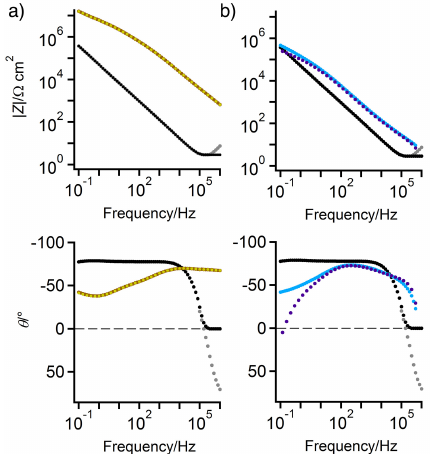
Figure 3. Impedance modulus and phase plots depicting the subtraction of the cell impedance from test panel spectra W (column a) and PA (column b). For all plots, both the cell impedance (gray) and the high frequency corrected cell impedance (black) are included for reference. In column ( a ), the W spectrum is shown both before (brown) and after (yellow) the subtraction of the corrected cell impedance. Similarly in column ( b ), the PA impedance is shown both before (blue) and after (purple) subtraction of the corrected cell spectrum. Briefly, mutual inductance from the instrument cables is observed at the highest frequencies, followed by a resistive region that represents the bulk resistance of the hydrogel and electrolyte, and at frequencies less than 5 kHz the cell spectrum is dominated by the capacitance of the electrolyte double layer at the hydrogel/foil interface. Given that the high frequency inductance was an instrumental artifact, it was removed from the cell spectrum and the resistive region was extended to cover the higher frequencies as shown in the corrected cell spectra in Figure 3. For each system measured, the corrected cell impedance ( Z cell ) was subtracted from the total impedance ( Z tot ) for both the real ( Z ’) and imaginary ( Z ”) components as shown in Equations (6) and (7). (cid:1852) (cid:2929)(cid:2931)(cid:2912)(cid:4593) (cid:3404) (cid:1852) (cid:2930)(cid:2925)(cid:2930)(cid:4593) (cid:3398) (cid:1852) (cid:2913)(cid:2915)(cid:2922)(cid:2922)(cid:4593)